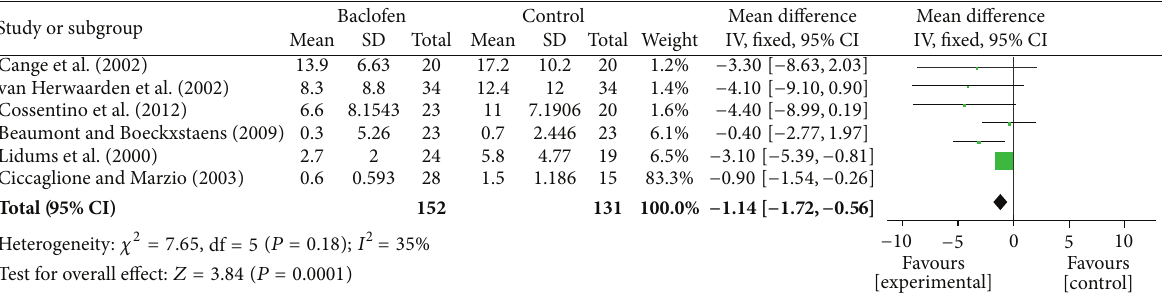
Figure 3: Meta-analysis of the acid reflux time in the PP population given either baclofen or placebo for the treatment of GERD.